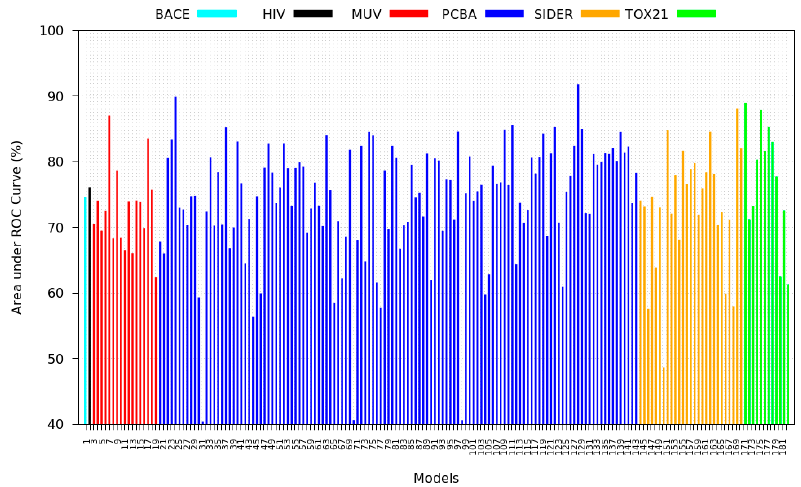
Figure A1. Detailed results of transfer learning from each source model after fine-tuning on the target dataset.